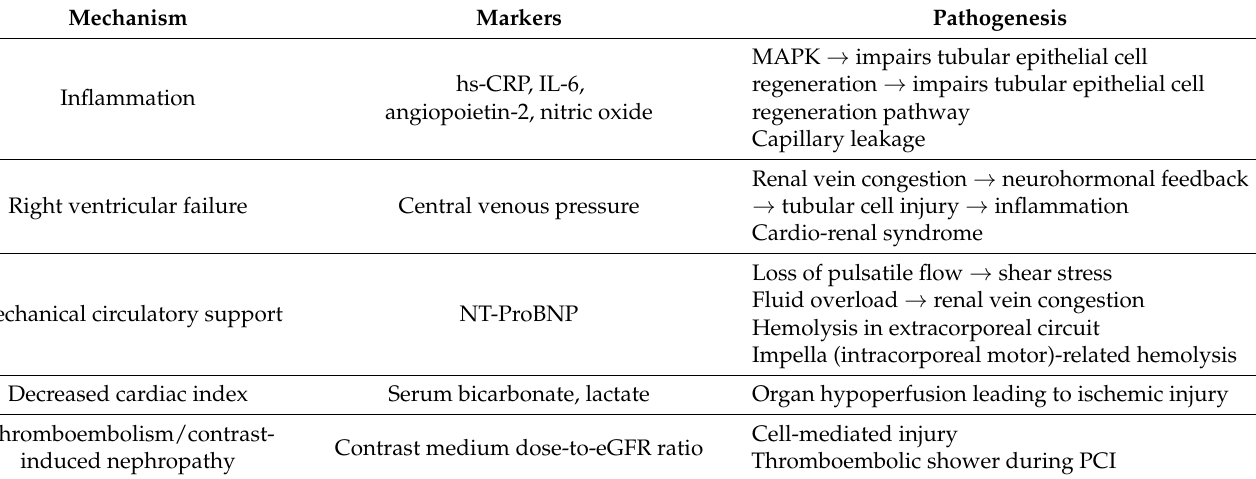
Table 1. Acute kidney injury in acute myocardial infarction-cardiogenic